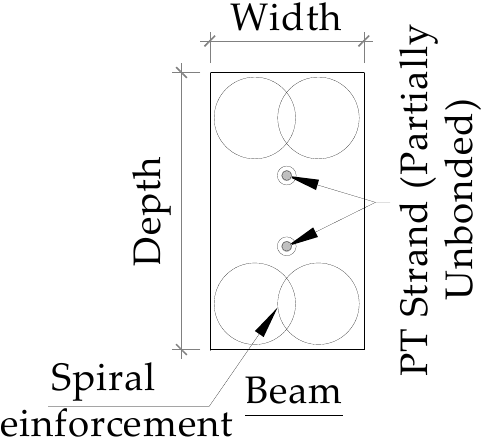
Figure 22. Spiral reinforcement at the compression zones.